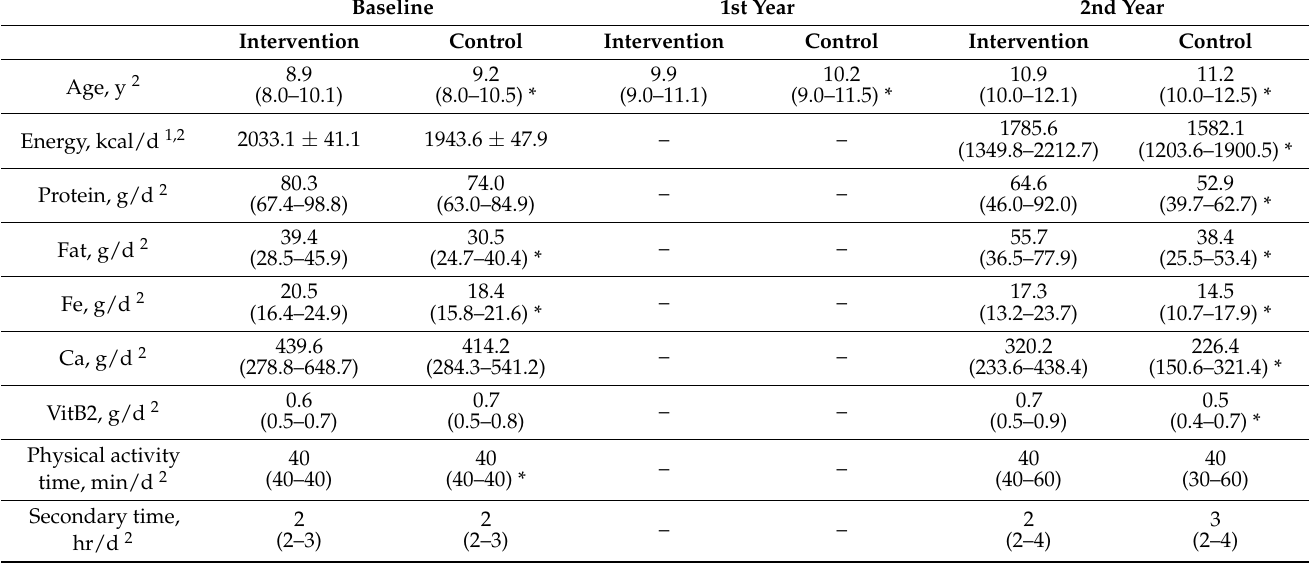
Table 3. Comparison of dietary intake and physical activity between the intervention group and the control group at baseline and second year (mean ±